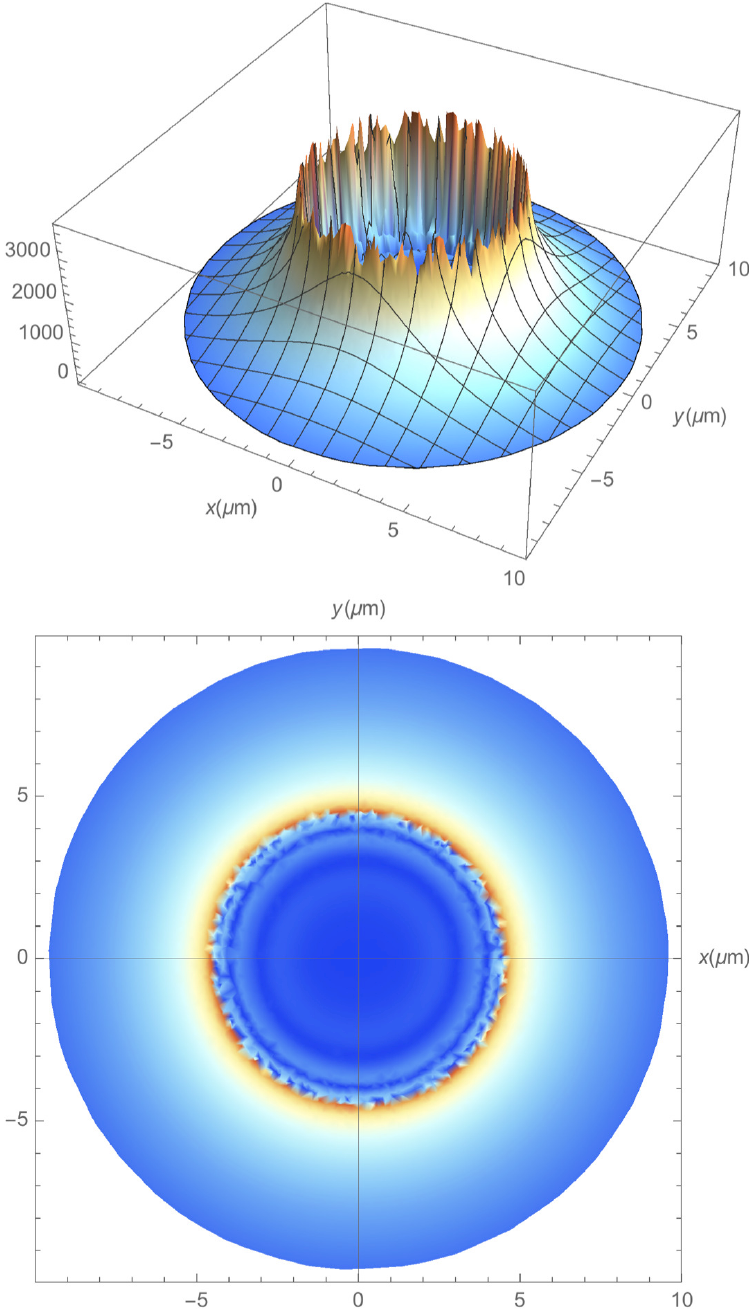
Figure 17. ( Top ) panel, 3D plot of the asymptotic kinetic energy for an uniform random distribution (cid:113) + y 2 ≤ 1.5 × w x 2 of initial conditions fulfilling ρ 0 = 0 and full paraxial fields. Vertical axis units are 0 0 keV. ( Bottom ) panel, the 2D density plot of top panel. The distribution shows rotational symmetry around the propagation axis, but very different shape and maximum kinetic energy as compared with the w 0 = 100.0 µ m